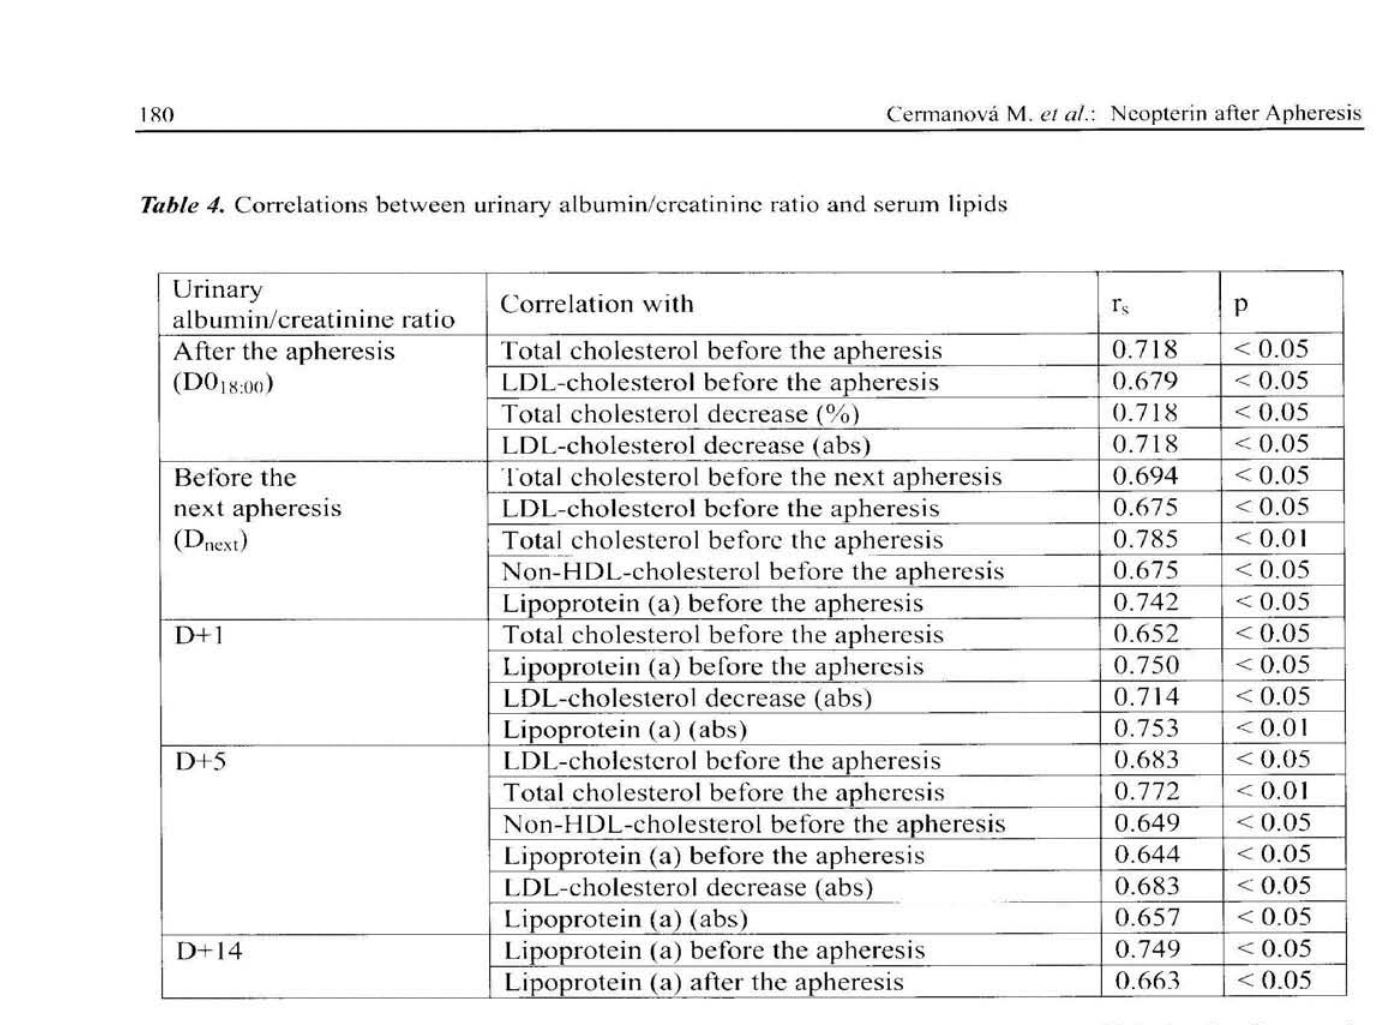
Table 4. Correlations between urinary albumin/creatinine ratio and serum lipids